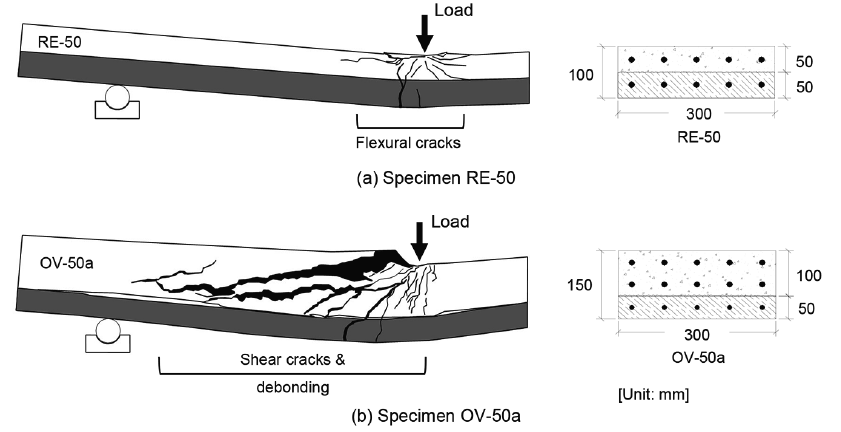
Figure 2. Typical crack patterns observed for the specimens in the RE and OV series (Yin et al. 2017)